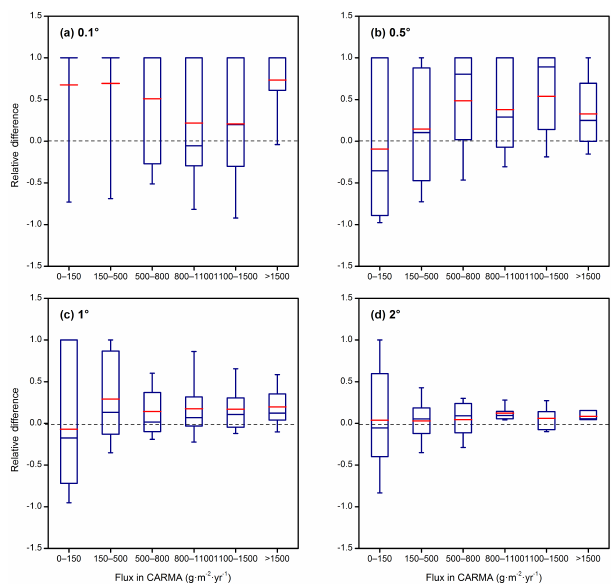
Figure 14. Comparisons of CO 2 emissions between CARMA and CPED for various spatial resolutions (from 0.1 to 2 ◦ ) in 2009. The box plots show the binned relative differences (a–b)/(a + b), where a is the CARMA estimate, and b is the CPED estimate. The blue horizontal line is the median of the relative differences, the red hor- izontal line is the mean of the relative differences, the box denotes the 25 and 75% percentiles, and the whiskers denote the 10 and 90% percentiles. A perfect agreement would correspond to a me- dian and mean equal to